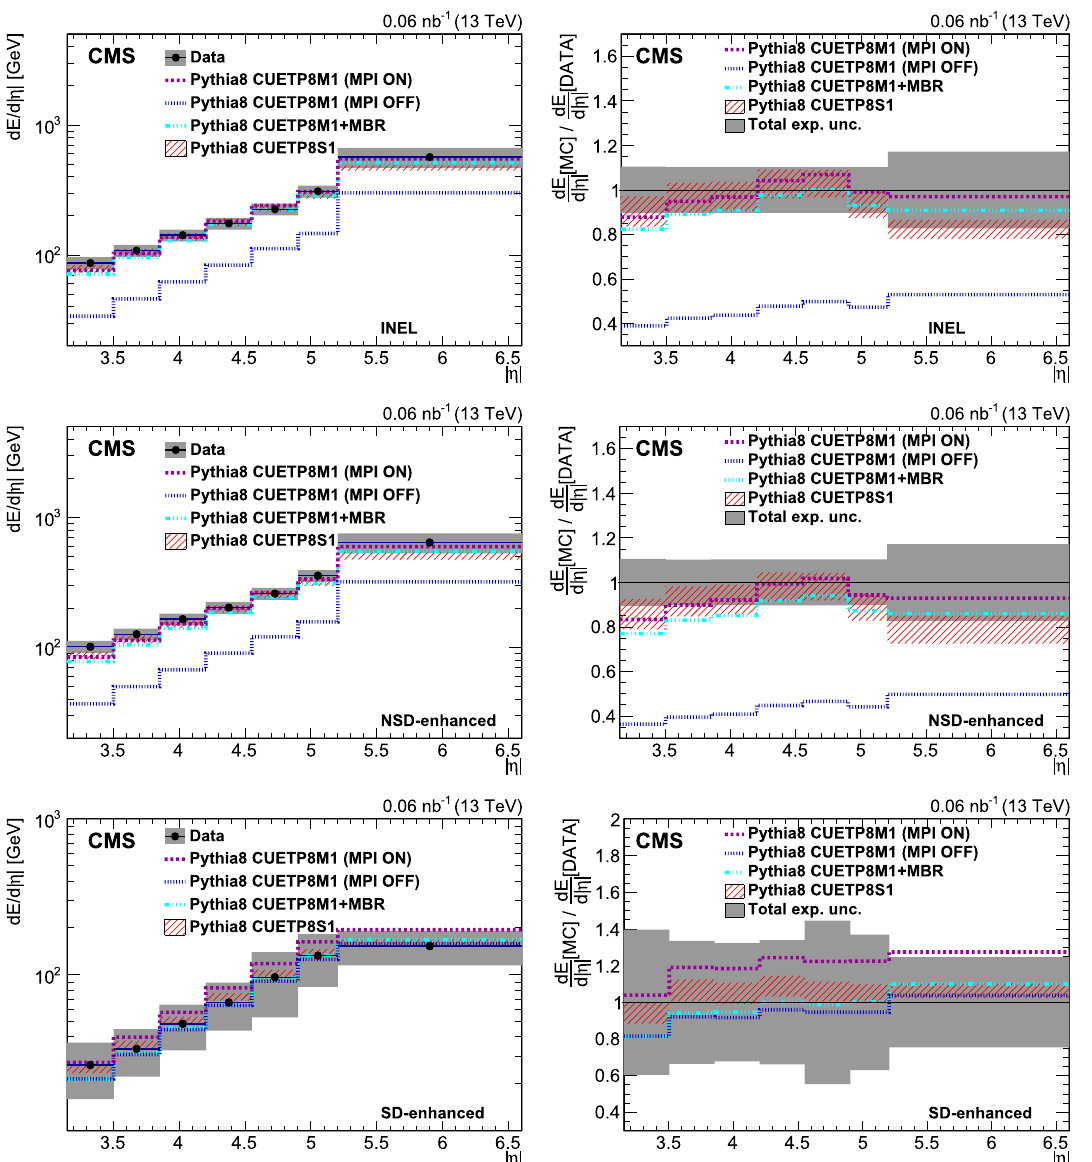
Fig. 3 Energy density at the stable-particle level for the INEL (upper row), NSD-enhanced (middle row), and SD-enhanced (lower row) cate- goriescomparedtopredictionsfrom pythia 8withthetunes cuetp8m1 , cuetp8m1+mbr , and cuetp8s1 . The gray band shows the total system-